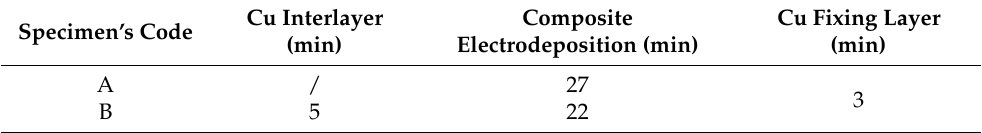
Table 2. Process durations for the